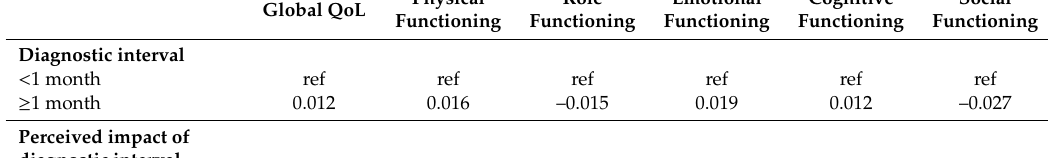
Table 3. Standardized betas of multivariable linear regression analysis evaluating the association of the diagnostic interval and other variables with EORTC QLQ-C30